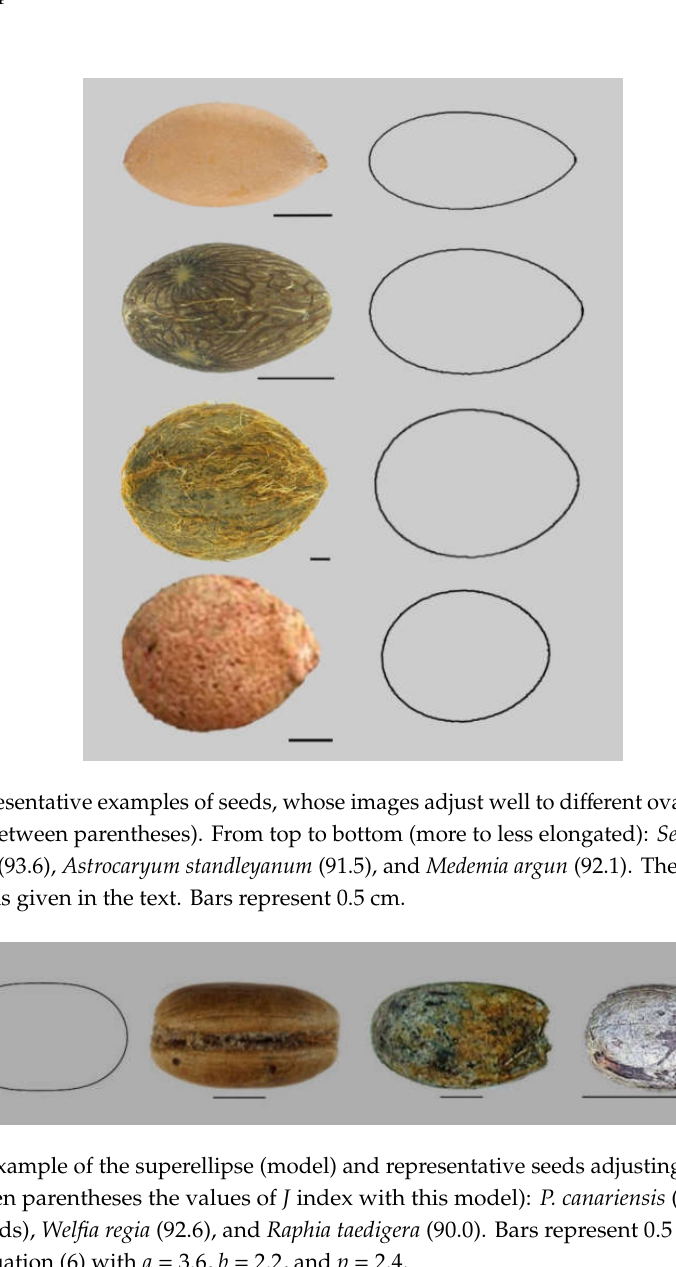
Figure 7. An example of the superellipse (model) and representative seeds adjusting to models in this family (between parentheses the values of J index with this model): P. canariensis (92.15 is the mean value of 25 seeds), Welfia regia (92.6), and Raphia taedigera (90.0). Bars represent 0.5 cm. The model is defined by Equation (6) with a = 3.6, b = 2.2, and p = 2.4.